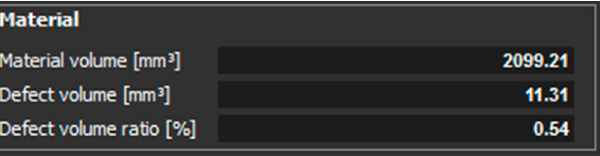
Figure 18. Measured values for the sample with thickness of 3 mm, which was oriented in XZ.